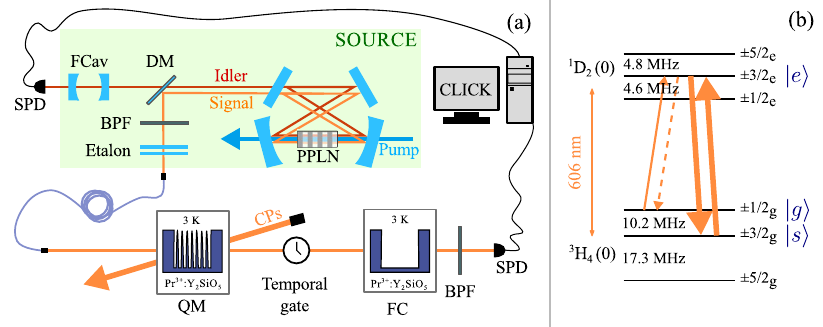
FIG. 1. (a) The experimental setup. Photon pairs are created by cavity-enhanced spontaneous parametric down-conversion (SPDC) in a periodically poled lithium niobate (PPLN) crystal. At the output of the cavity, they are separated by a dichroic mirror (DM). The idler photon is further filtered with a cavity (FCav) to select a single frequency mode, before being coupled in an optical fiber and detected with an InGaAs single-photon detector (SPD). The signal photon is spectrally filtered with a band-pass filter (BPF) and an etalon, before being coupled in a single-mode optical fiber and directed towards the quantum memory (QM), where it is stored using the AFC scheme. Control pulses (CPs) are used to transfer optical excitations to spin waves and back; they are sent at an angle and counterpropagating with respect to the input photons. The retrieved single photon is spectrally filtered using a filter crystal (FC) before being detected by a silicon SPD. Temporal filtering is achieved with acousto-optic modulators, placed after the memory crystal, opened only when we expect the SW echo. This prevents additional hole burning in the filter crystal and the SPD to be blinded by eventual leakage of the control pulses. During the preparation of the memory crystal via optical pumping, the SPDs of both idler and signal arms are gated off. After each AFC preparation, the gates are opened, and we detect the arrival time of both photons of the pair during a measurement time of about 100 ms, leading to a duty cycle of 0.14. (b) Hyperfine splitting of the first sublevels of the ground 3 H 4 and the excited 1 D 2 manifold of Pr 3 þ in Y 2 SiO 5 . The arrows highlight the Λ system chosen for the